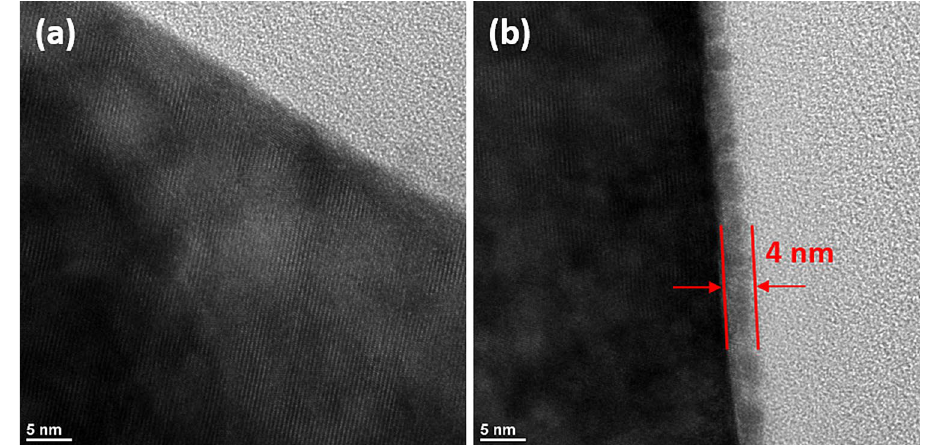
Figure 4. FETEM images of ( a ) Pristine and ( b ) LiP-0.1.